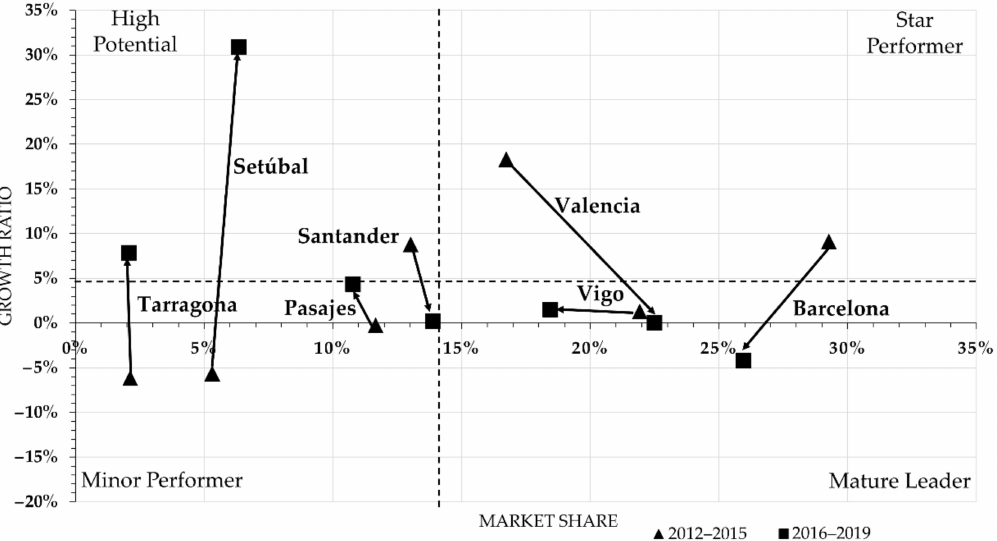
Figure 5. Matrix with dynamic portfolio analysis of port competitive positions for vehicle embarking traffic during the period from 2012 to 2019.